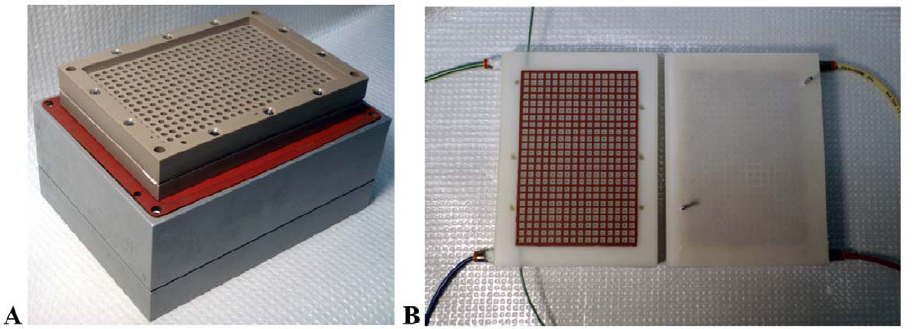
Figure 3. Mesofluidic devices for DNA-programmed synthesis. ( A ) The chemistry apparatus on top of a Qiagen multi-well plate manifold. The top half of the device has a large trough to hold fluid for wash steps, and the bottom half has a raised surface that acts as an array of drip directors to facilitate the collection of material. The interior surfaces of the plates are grooved to accommodate silicone gaskets. ( B ) The two halves of the mesofluidic pump prior to assembly. An anticodon array is loaded onto the right plate of the pump. Throughout the temperature cycle, the DNA library is circulated over all 384 features of the anticodon array. The thick colored tubing at the top and bottom of each plate delivers compressed air or vacuum to a subset of the diaphragm features in the plate. The thin green tubing at the top and bottom of the left plate is the liquid inlet/outlet.